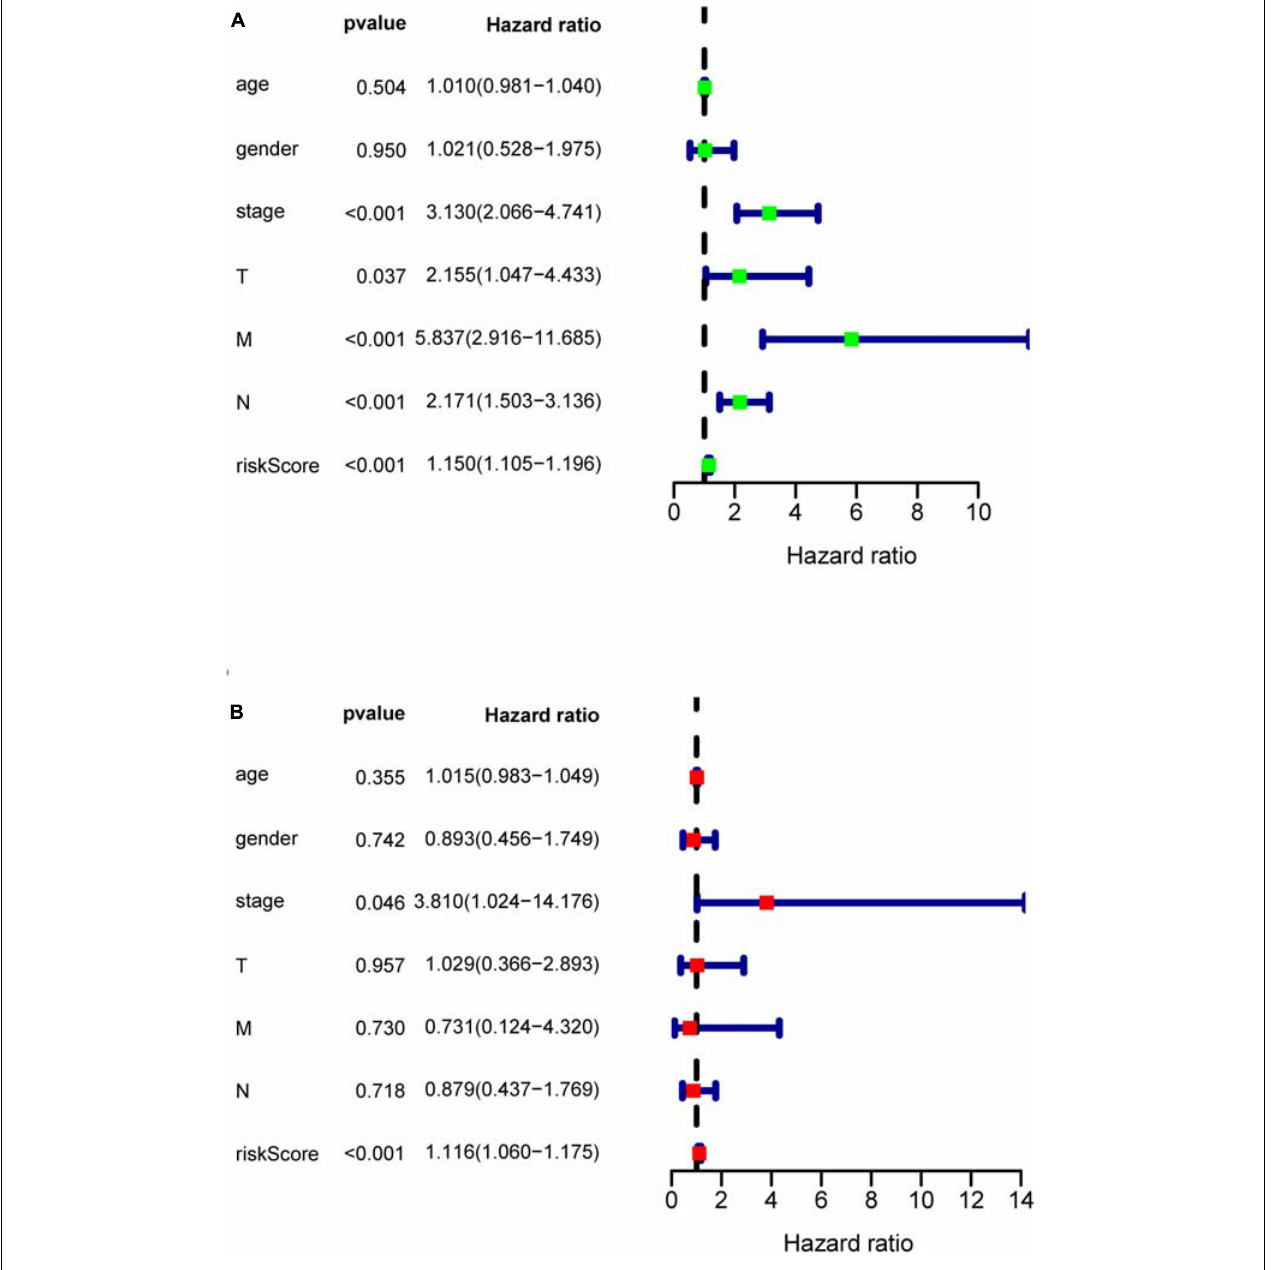
FIGURE 6 | COX regression analysis for assessing the independent prognostic value of riskScore. (A) Univariate regression analysis. (B) Multivariate regression analysis. In univariate and multivariate independent prognostic analyses, if both P -values of riskScore are less than 0.05, riskScore could become an independent prognostic